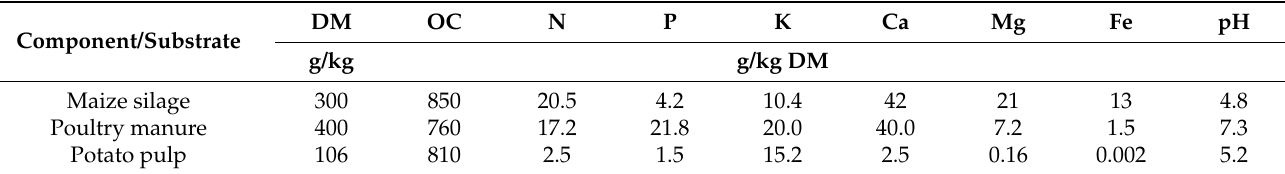
Table 1. The physicochemical composition of substrates used in